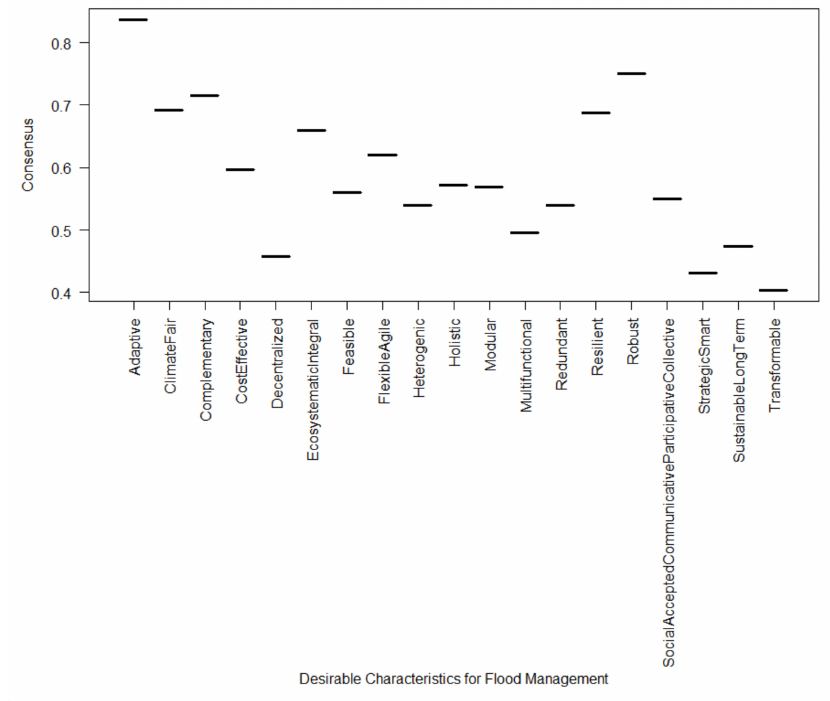
Figure A9. Agreement (consensus) among survey participants of the desirability of characteristics for flood management to rural mountain areas (the higher value, the more homogeneous the given responses; scale from 0 to